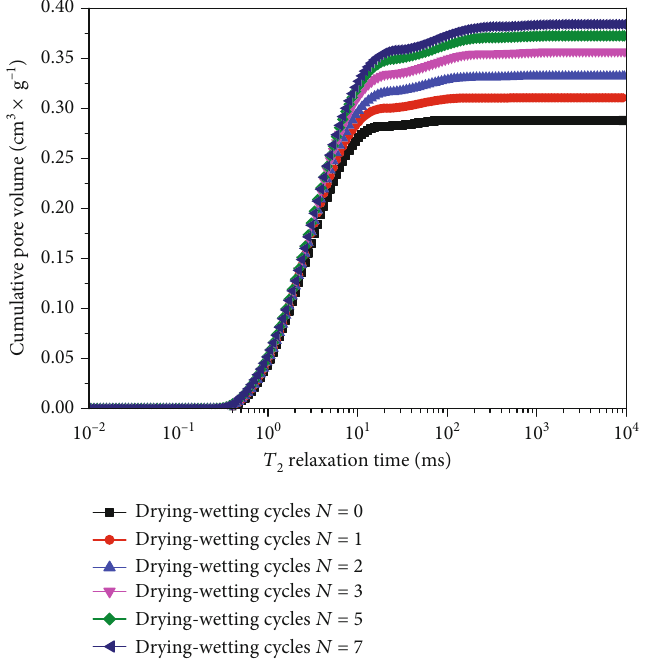
Figure 9: Relationships between cumulative pore volume and T